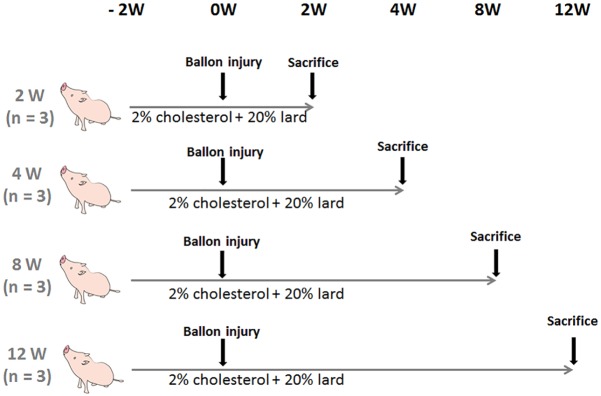
Study protocol.Twelve two-month-old LDLR-KO pigs were randomly allocated to four groups (n = 3 each) and fed with a diet containing 2.0% cholesterol/20% fat throughout the study. The coronary arteries were injured using balloons and then the pigs were sacrificed at 2, 4, 8 and 12 weeks later. Coronary plaque development was accelerated in all pigs by angioplasty of left anterior descending and left circumflex arteries.